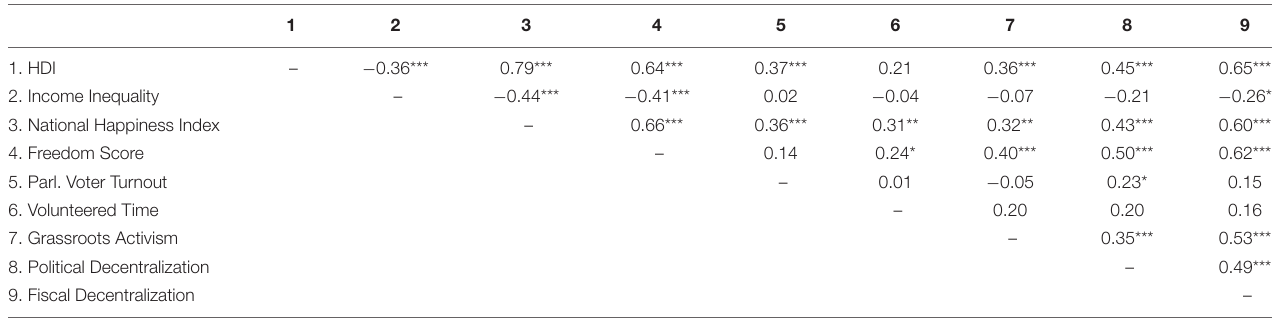
TABLE 2 | Correlations among measures and predictors of national